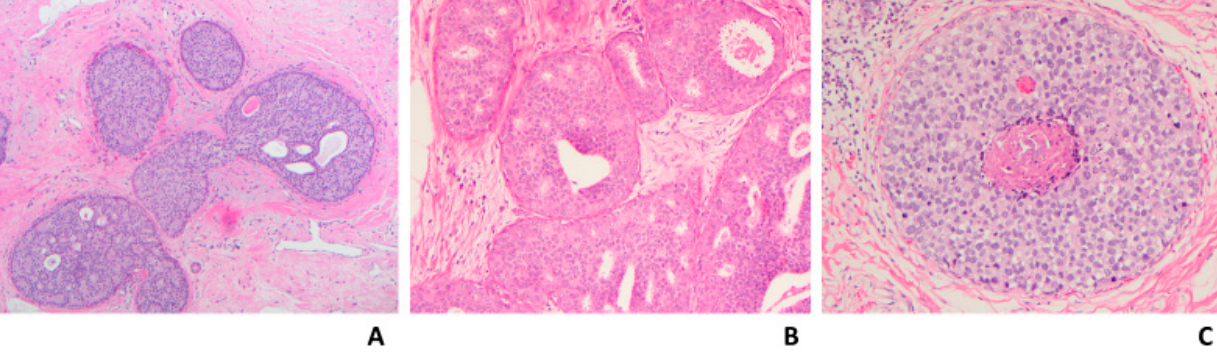
Figure 5. DCIS nuclear grades: ( A ) LG-DCIS: small monophonic cells arranged in a cribriform pattern (H&E, 10×); ( B ) IG-DCIS: ductal cells with moderate variability in size arranged in a cribriform pattern (H&E 20×); ( C ) HG-DCIS: Marked nuclear pleomorphism with many mitotic figures, apoptotic bodies and central necrosis arranged in a solid growth pattern (H&E 20×).